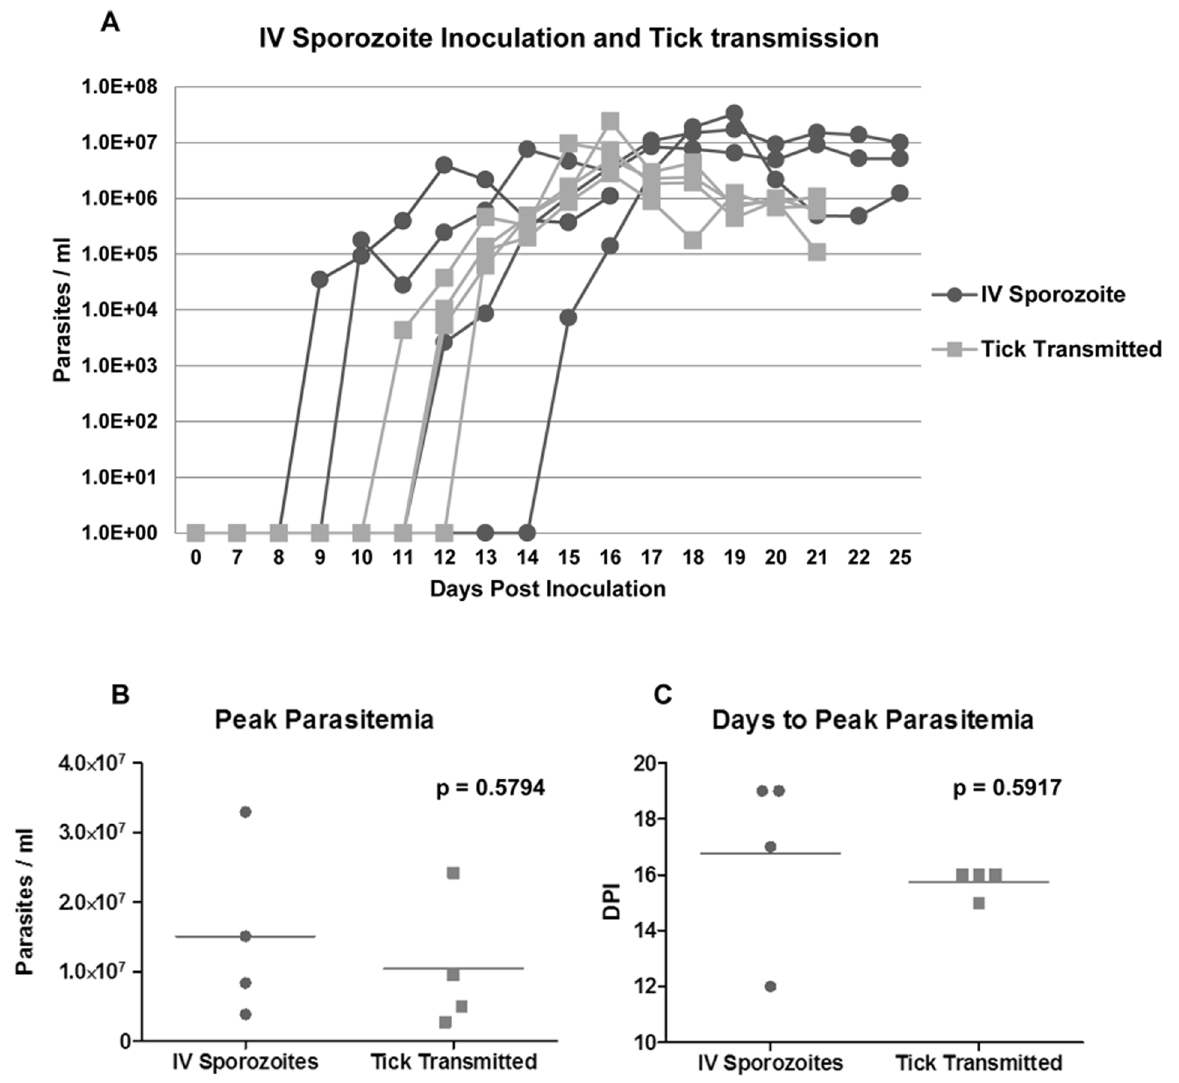
Figure 1. Acute parasitemia after IV sporozoite inoculation and tick-transmission. A. Course of parasitemia (parasites/ml whole blood) for horses infected with T. equi sporozoite ( , 1 6 10 5 –10 6 ) by intravenous inoculation or by tick-transmission was assessed by quantitative real time PCR. Levels of peak parasitemia (B) and days to peak parasitemia (C) between groups were compared using a t test with a =0.05. DPI, days post inoculation.